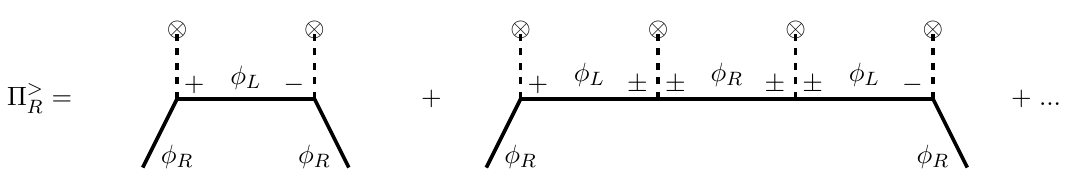
. The R have the same structure with the R